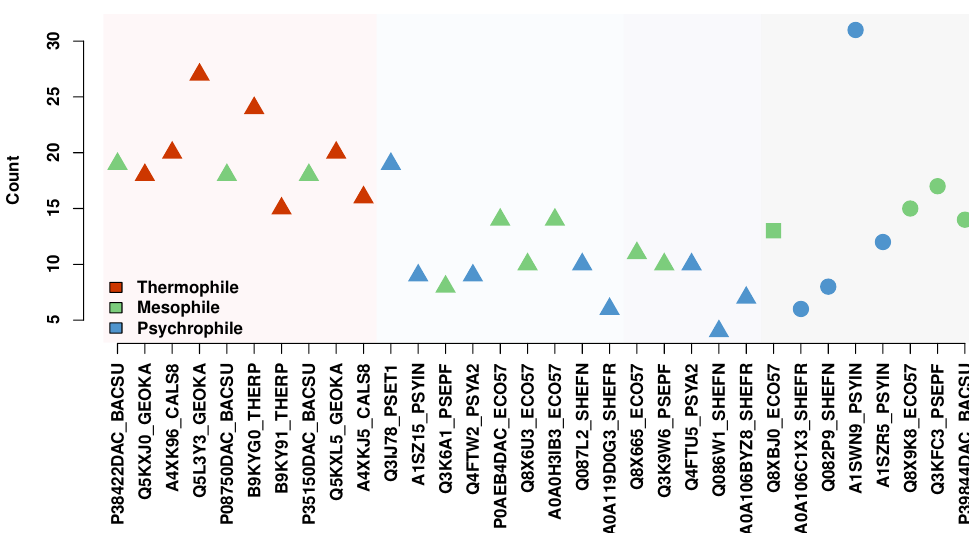
Figure 15. Counts of salt bridges by protein. Thermophiles show higher salt bridge counts overall, though two psychrophiles show comparable